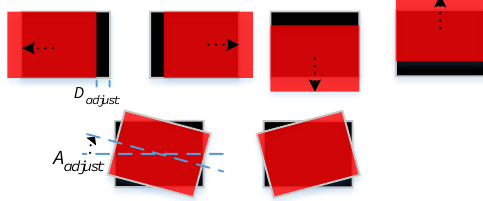
A ad j u s t Figure 5. Small range adjustment of matching centre and direction